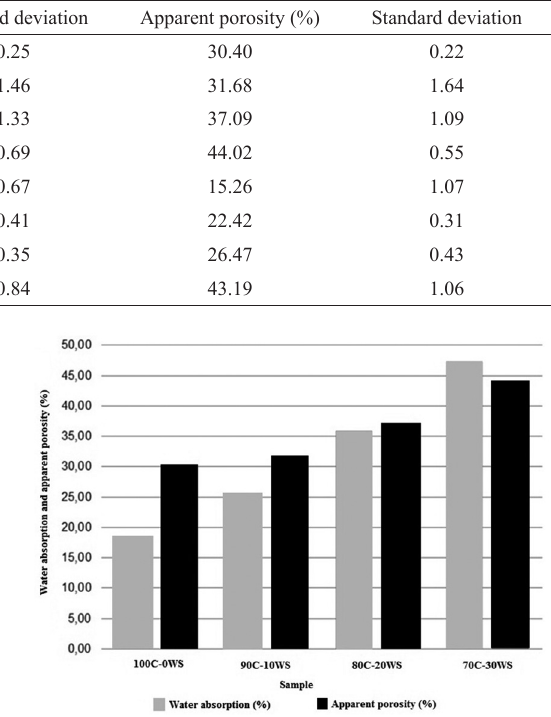
Table 6: Water absorption and apparent porosity of calcined